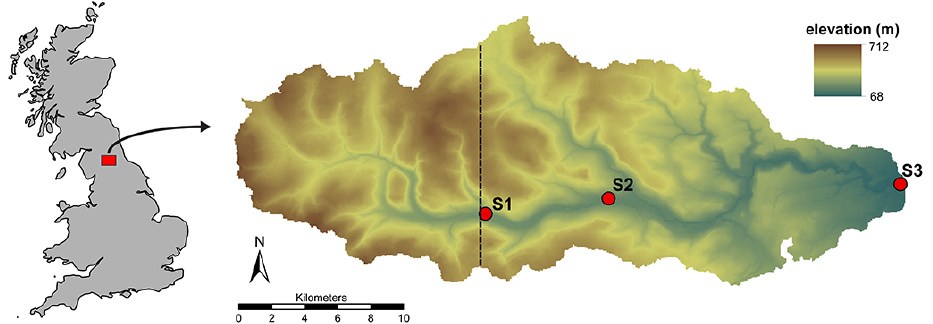
Figure 1. Location map (left) and elevation map (right) of the Swale basin. The area to the west of the fault line (dashed black line) was uplifted in the uplift simulations. Points S1, S2 and S3 indicate three locations where simulated sediment yields were recorded, respectively corresponding to a small, medium and large upstream sub-basin. Point S1 is located immediately downstream of the fault line. Points S2 and S3 are 10 and 30km downstream from the fault line. Table 1. Sediment yields in uplift scenarios for 100yr simulations. scenario S1 S2 S3 cum. yield rel. change cum. yield rel. change cum.